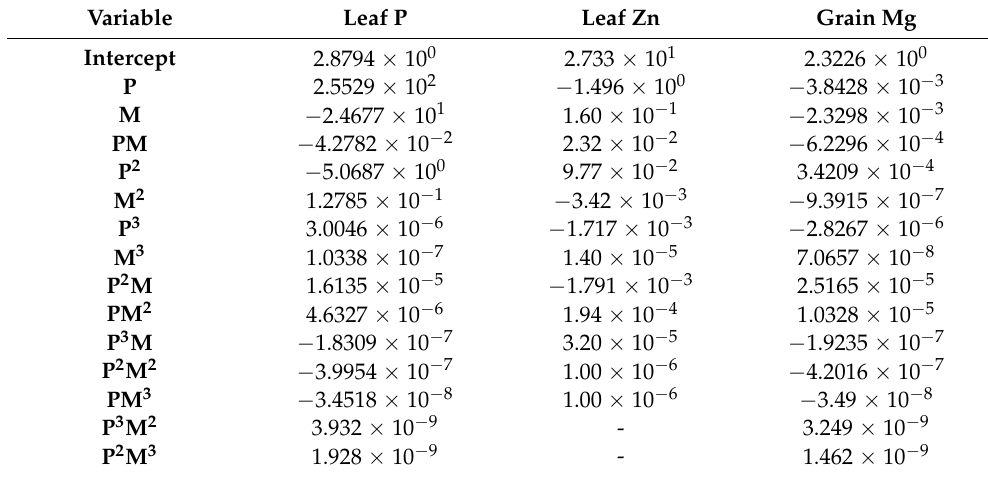
Table 2. Values of the equations referring to the response surfaces adjusted for the effect of the interaction between P 2 O 5 doses and the mycorrhizal inoculant used on leaf phosphorus, leaf zinc, and grain magnesium contents in the 2020 corn